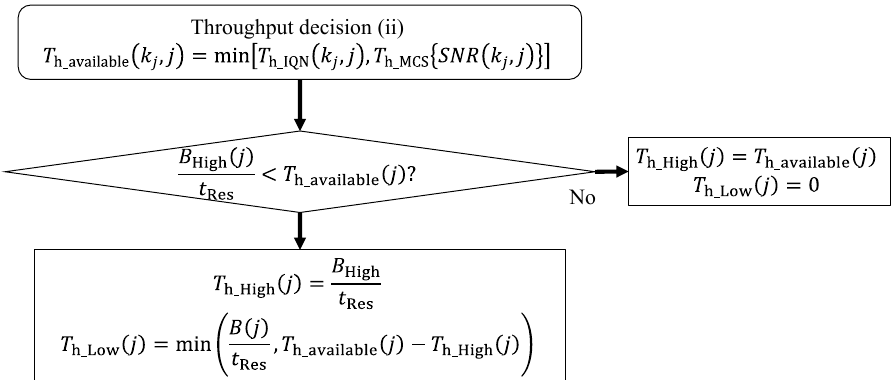
Figure 6. Conventional throughput decision flowchart at vehicle.